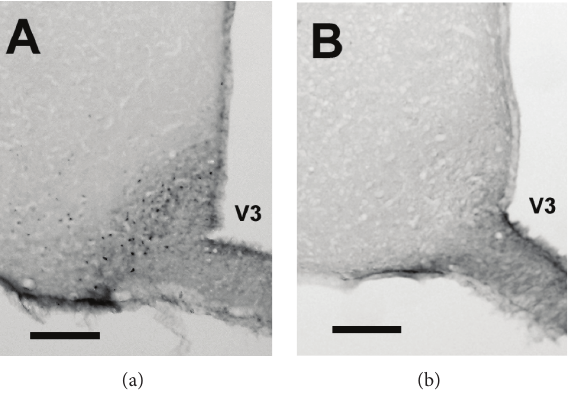
F 5: Representative coronal micrographs of immunohisto- chemistry c-Fos staining (black) in the arcuate nucleus of the hypothalamus.Animalsexposedtoahigh-fatdietwereinjectedwith either nisoxetine (3mg/kg; (a)) or saline (b) following a 24h food deprivation. Animals were sacri�ced 2h a�er injection. e bar in each image represents 160 m. Coordinates for the representative sections were 3mm caudal from bregma. Abbreviation: V3 = third ventricle. 𝜇𝜇